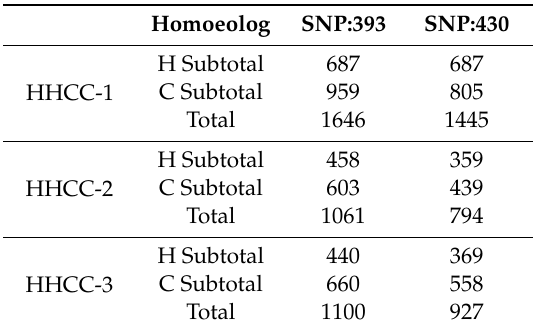
Table 1. rbcS homoeolog expression in Cucumis allopolyploid C. ×